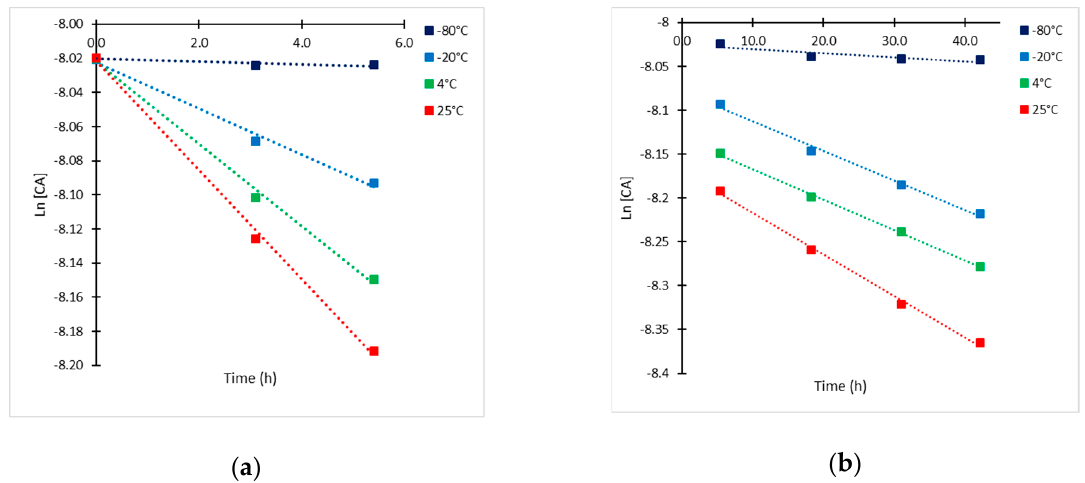
Figure 3. Semi-log plots of CA concentration (CA o = 65.5 mg/L) at − 80, − 20, 4 and 25 ◦ C. ( a ) t ≤ 6 h; and ( b ) t > 6